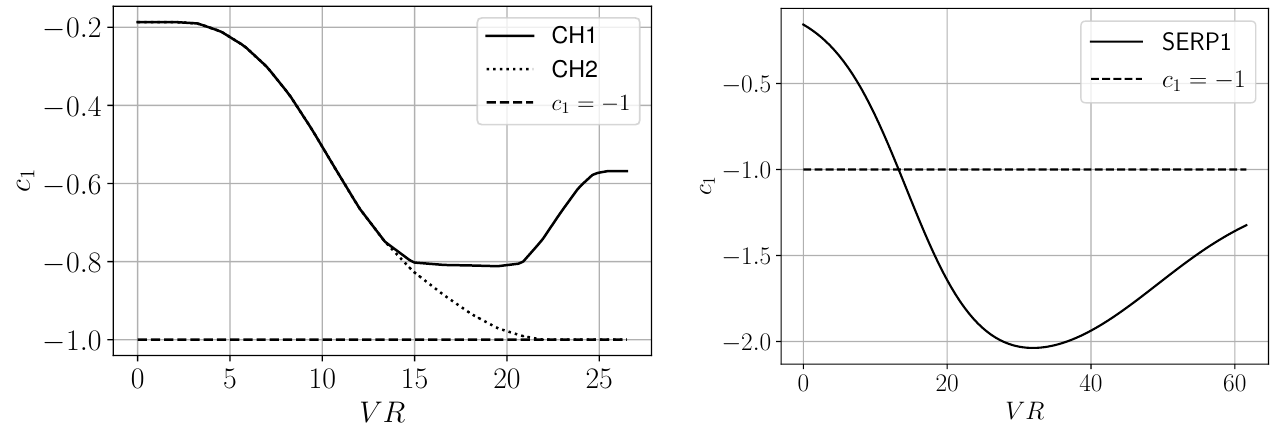
Figure 4. c 1 models: CH1, CH2 for the channel ( left ) and SERP1 for the serpentine ( right